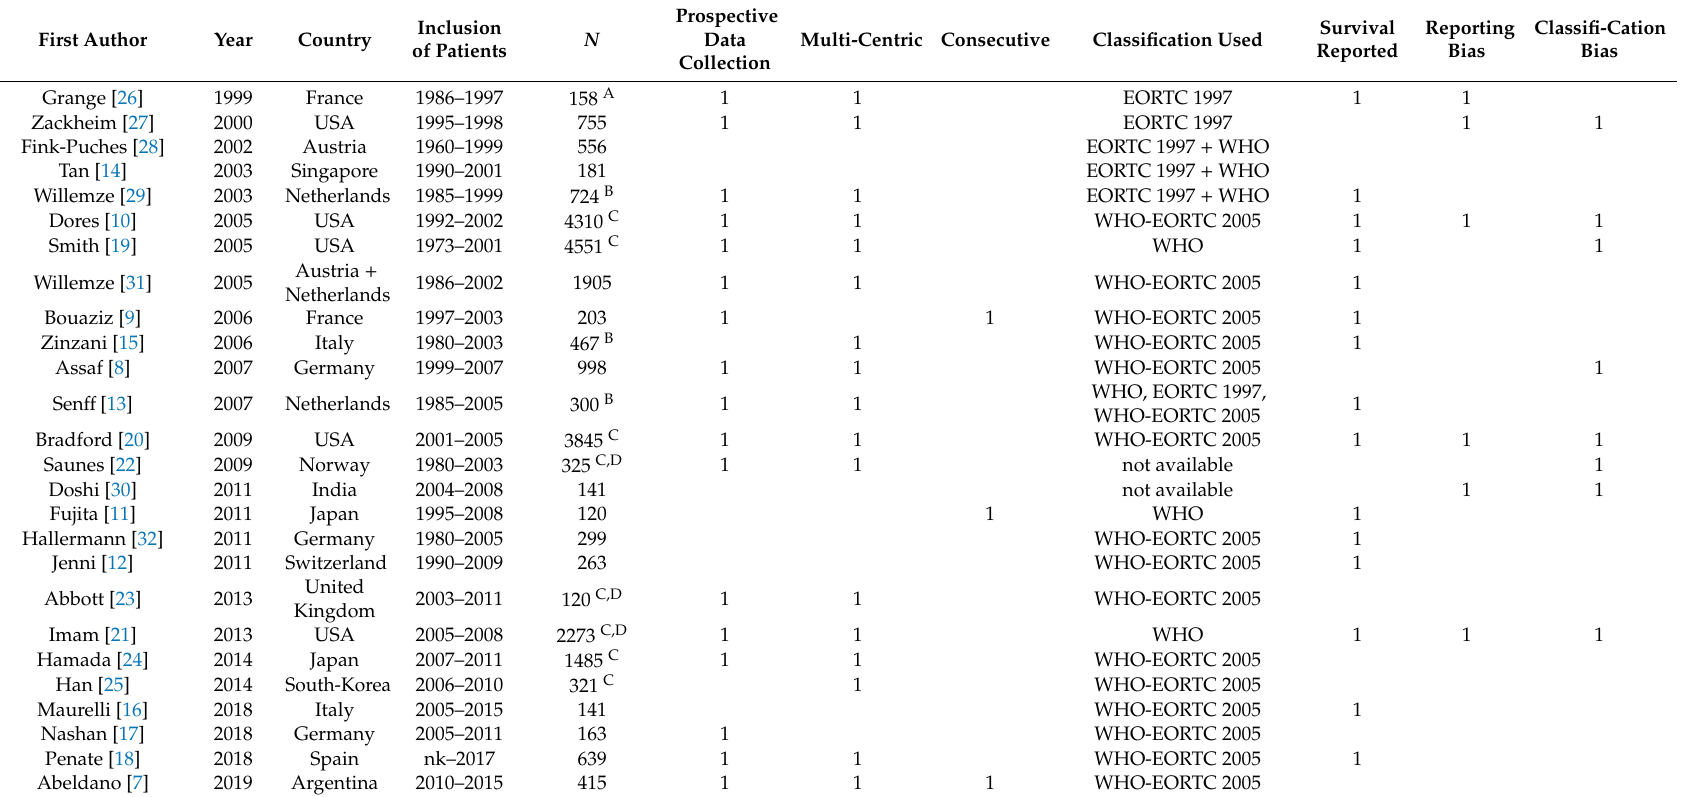
Table 1. Characteristics of included